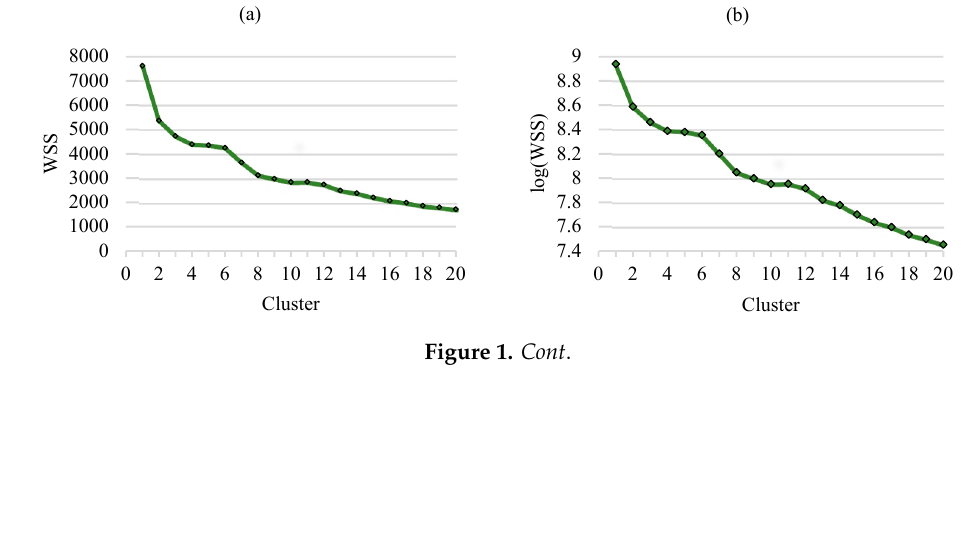
Figure 1. ( a ) within sum of squares (WSS) , ( b ) log (WSS), ( c ) 𝜂 (cid:2870) , and ( d ) proportional reduction of error ( PRE) for all K cluster solutions. Figure 2 illustrates the annual average electricity consumption patterns of the four clusters. Figure 2. Annual average electricity consumption patterns (kWh) by the hours of the day of the four clusters. Households belonging to Cluster 1 represent 40.3% of the sample ( n = 27), followed by Cluster 2 (31.3%; n = 21), Cluster 3 (16.4%; n = 11), and Cluster 4 (11.9%; n = 8). Table 2 shows the variation in the annual average base consumption (kWh), average consumption (kWh), and average peak consumption (kW) among the four identified clusters.